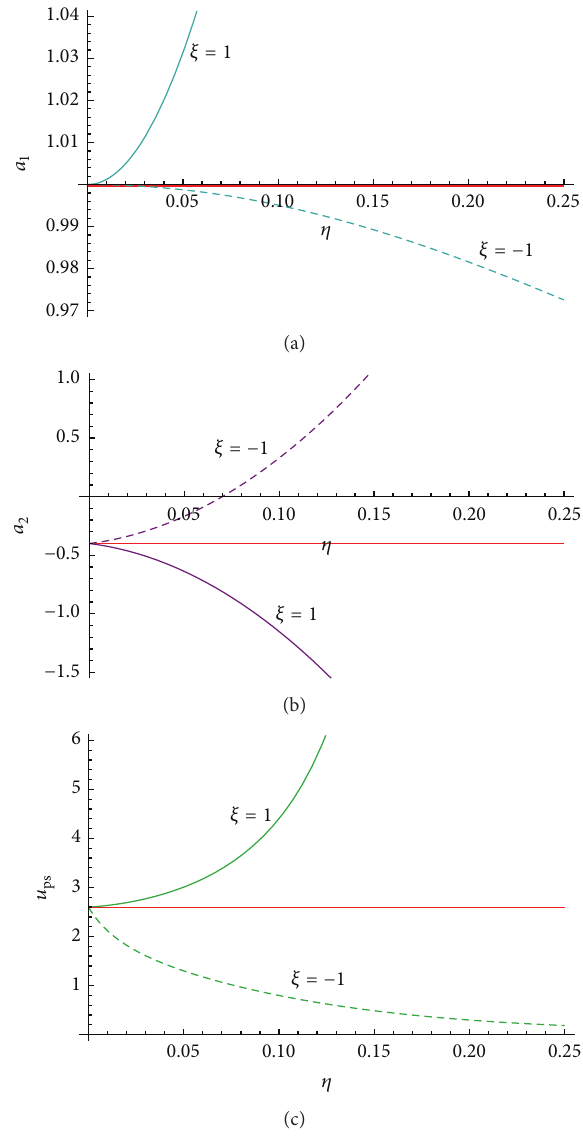
Figure 4: Behavior of strong field deflection coefficients ( 𝑎 1 (a) and 𝑢 𝑎 (c) as functions of 𝜂 are represented by 2 (b)) and parameter ps blue, purple, and green while red line shows Schwarzschild